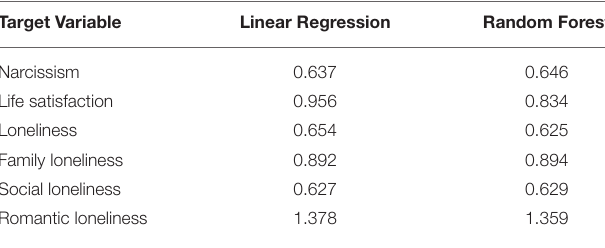
TABLE 5 | Root mean square error in 10-fold